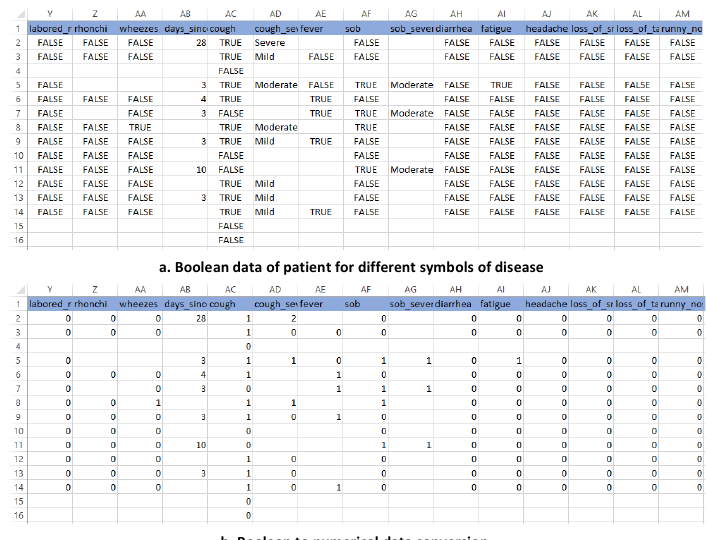
Figure 4. Categorical data into numerical data.